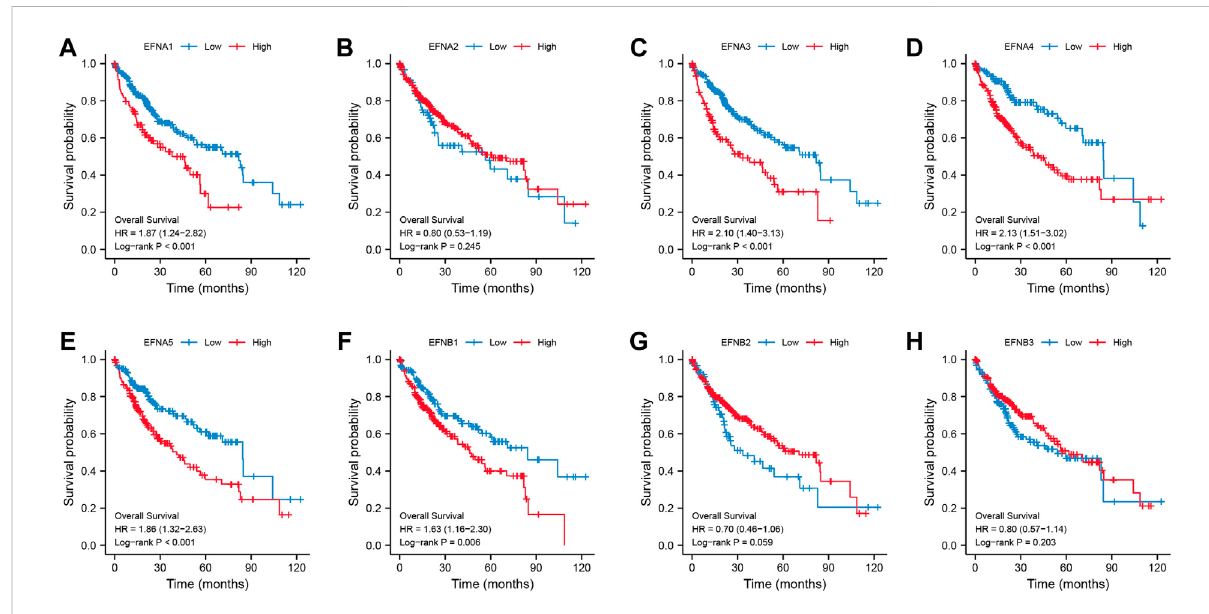
FIGURE 2 Correlation of ephrin genes expression with overall survival (OS) in patients with HCC based on Kaplan-Meier analysis (A – H)